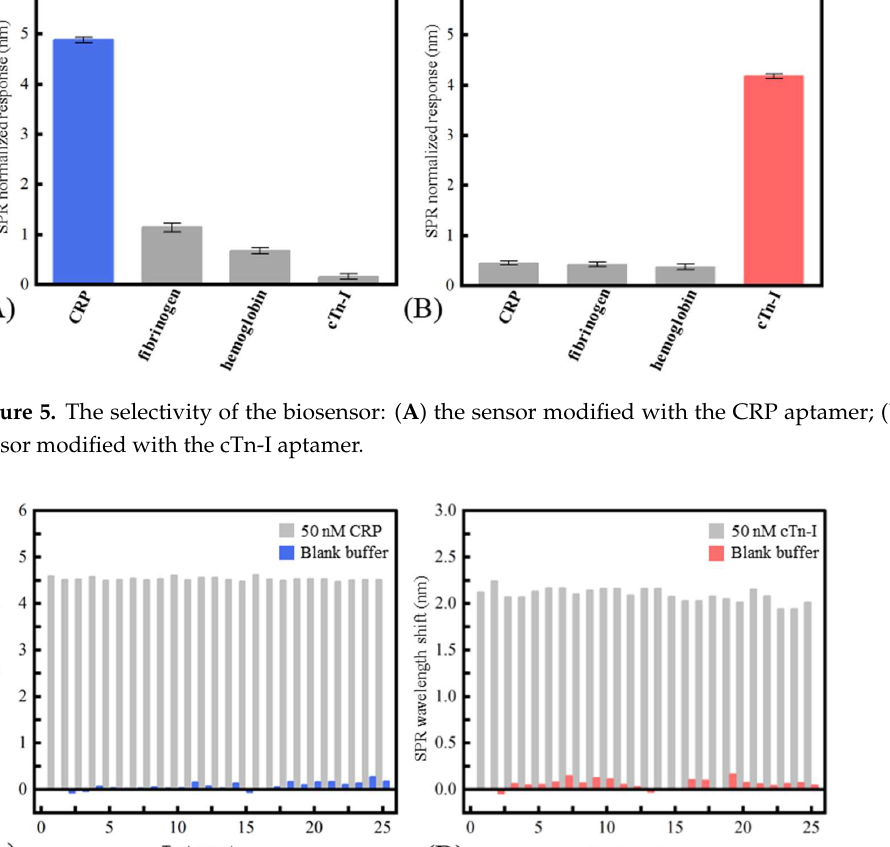
Figure 4. The sensor’s response to the CRP ( A ) and cTn-I ( B ) under different concentration aptamer modification. The responses of the sensors were modified with different concentration aptamers under the 111 nM CRP ( C ) and cTn-I ( D ). The response and the detection limit of the biosensor to CRP ( E ) and cTn-I ( F ).